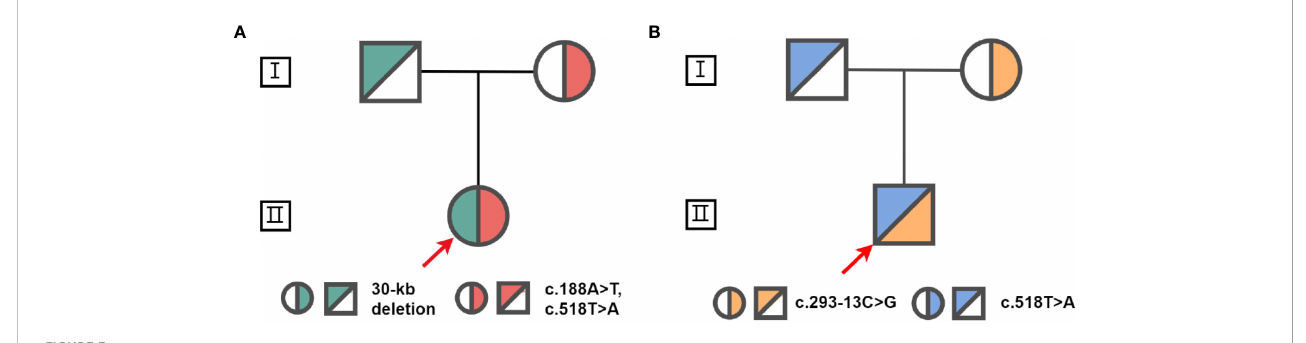
FIGURE 3 Pedigrees for families of proband 1 (A) and s proband 2 (B) . The red arrow indicates the